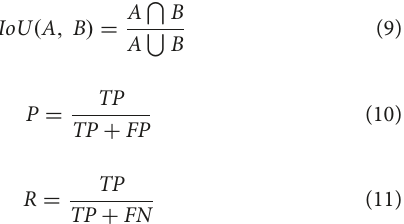
sigma to 5. Subplot (c) is grid distortion, its effect is similar to that of the elastic transform, which is a non-rigid body